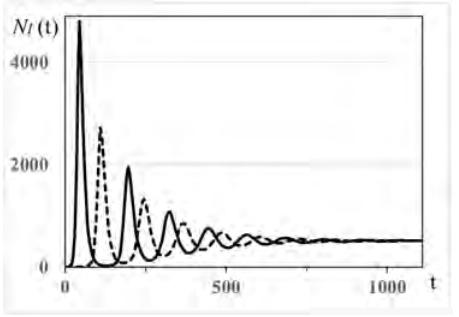
Fig. 14. of N I ( t ) for oscillating dynamics for 2 different initial values ϕ ( a ) .